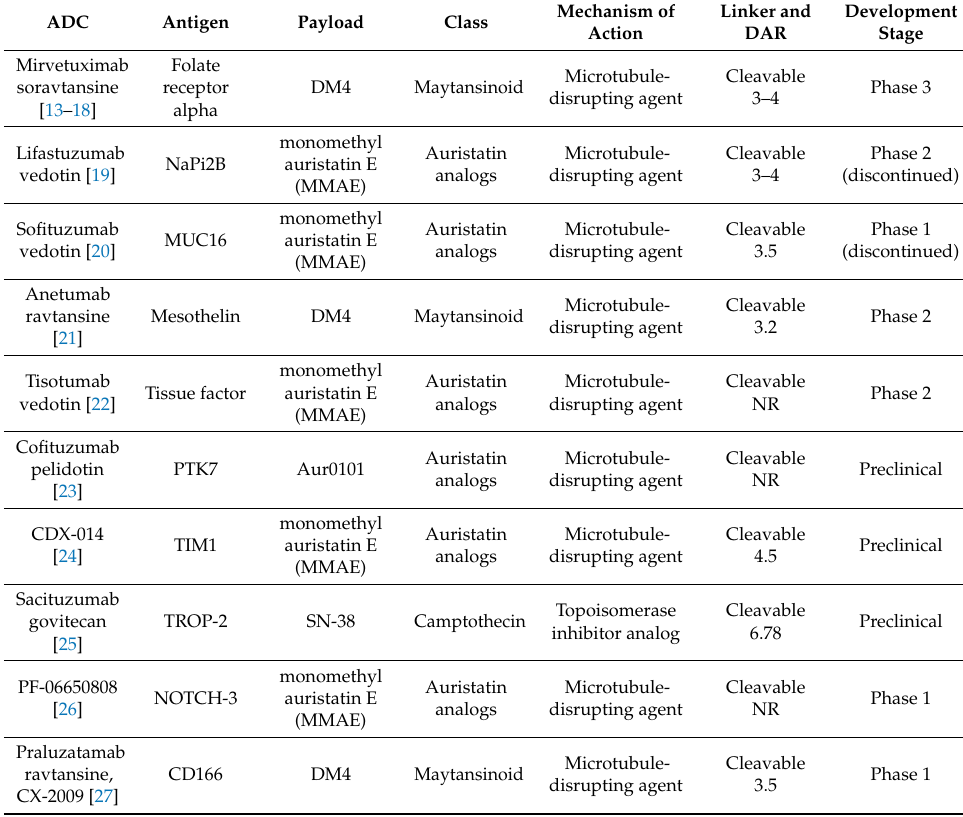
Table 1. Antigens and cytotoxic payloads for antibody-drug conjugates (ADCs) in clinical and preclinical development in ovarian